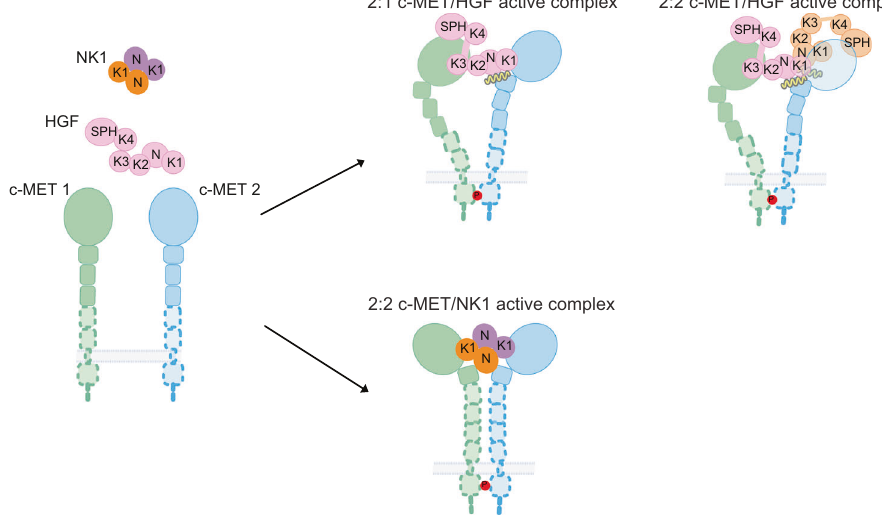
Fig. 7 Cartoon representation of a working model for HGF and NK1 induced c-MET activation. HGF induces an asymmetric c-MET signaling complex, whereas NK1 induces a symmetric c-MET signaling complex. The bindings of a second HGF and heparin strengthen the 2:1 c-MET/HGF active